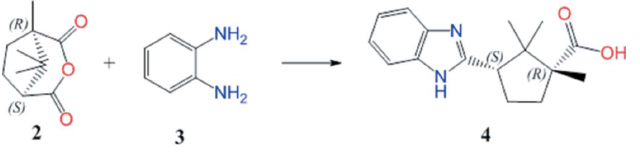
Figure 2 Synthesis of (1 R ,3 S )-3-(1 H -benzo[ d ]imidazol-2-yl)-1,2,2- trimethylcyclo- pentane-1-carboxylic acid, 4 .